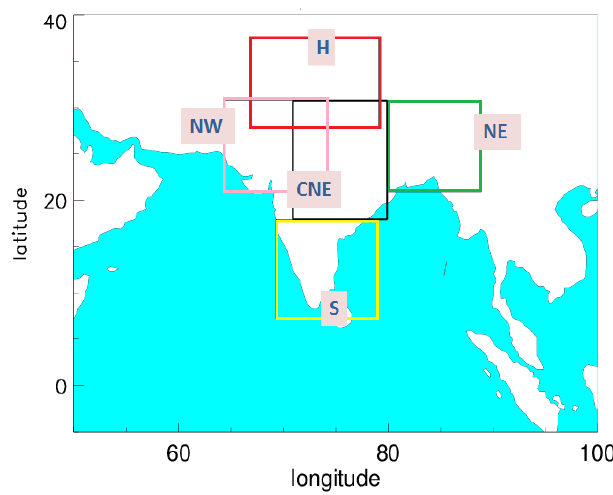
Figure 1. Map of Indian subcontinent demarcating various arbitrarily chosen boundaries: Central North East (CNE), Hilly (H), North West (NW), South (S) and North East (NE) regions of